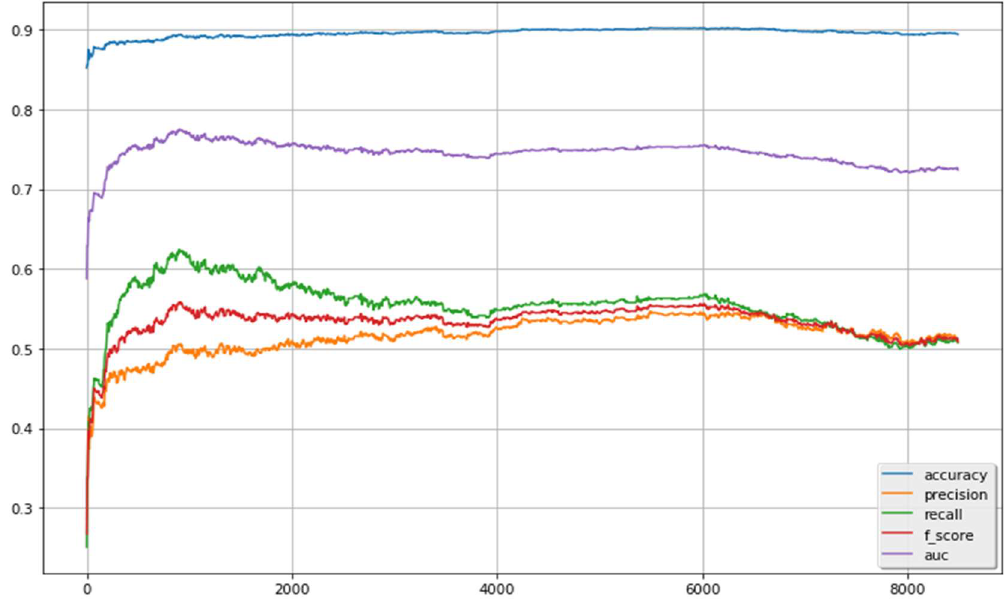
Figure 2. Results of the classifier with feature selection scheme.